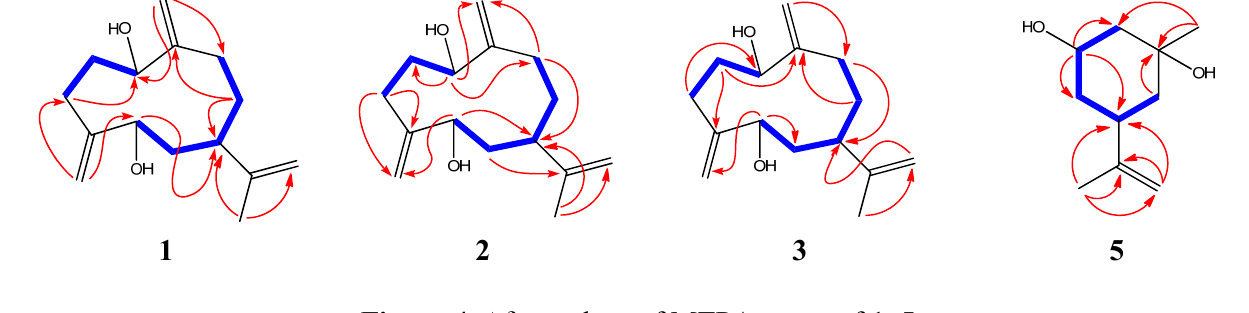
Figure 4. ∆ δ values of MTPA esters of 1 – 5 S-R